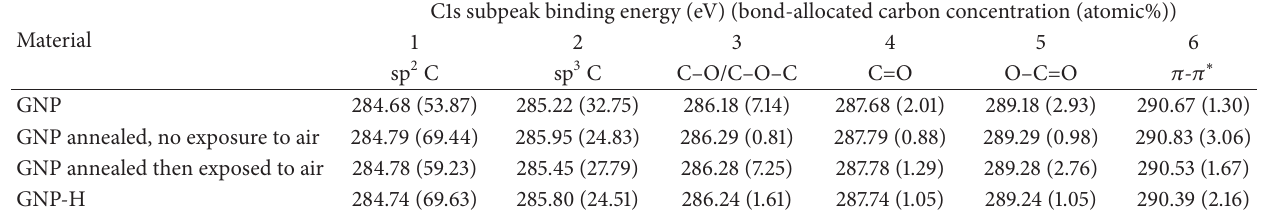
Table 2: The C1s peak position and the relative atomic percentage of various functional groups, corresponding to the deconvoluted peaks in Figure 5.